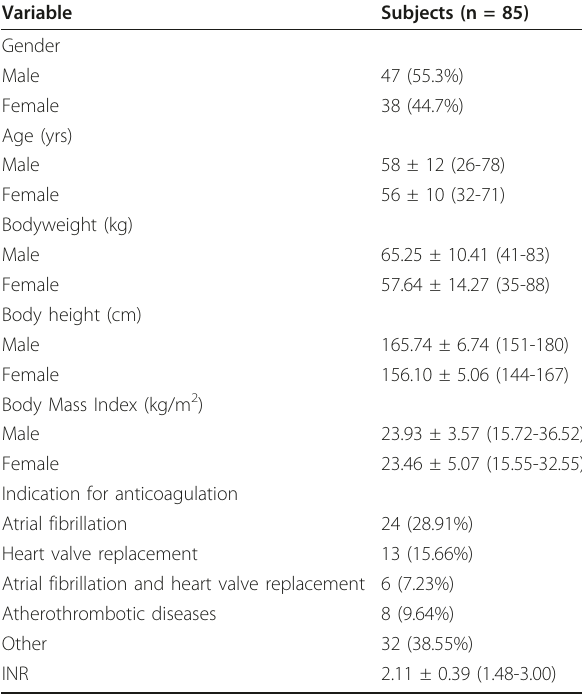
Table 1 Clinical characteristics of